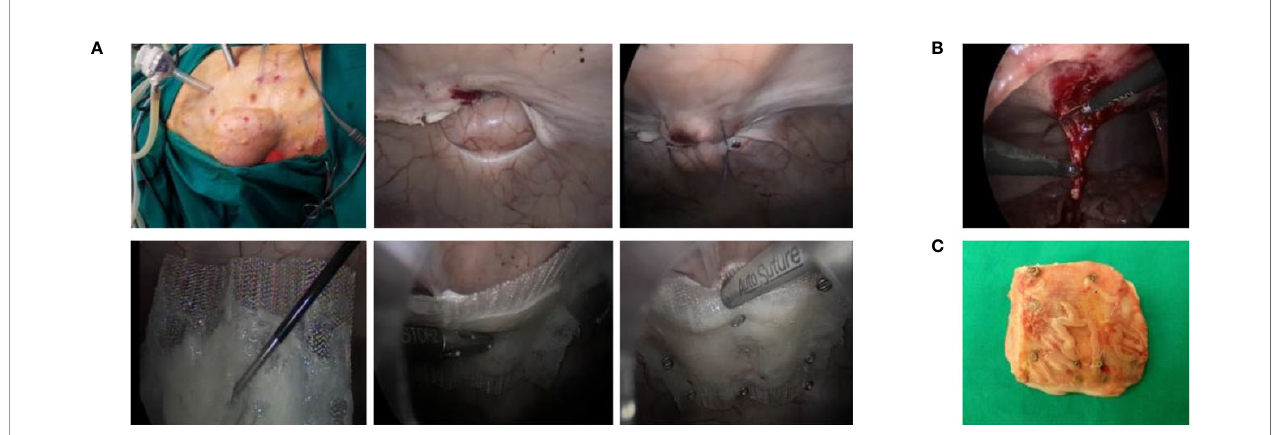
FIGURE 3 | Surgical approach. (A) The abdomen of the pig was insuf fl ated with CO 2 and the hernia ori fi ce was visualized from the outside and from the inside with a laparoscopic camera. Hernia borders were approximated by intracorporeal suturing. The rolled surgical meshes (prepared as shown in Supplementary Figure 1 ) were inserted into a trocar and placed in contact with the hernia. Then the mesh was fi xed with helicoidal staples. (B) Small biopsy samples of the mesh and its surrounding tissues were collected with Metzenbaum scissors 1 week after implantation surgery. (C) The meshes were excised following euthanasia of the animals 1 month after the